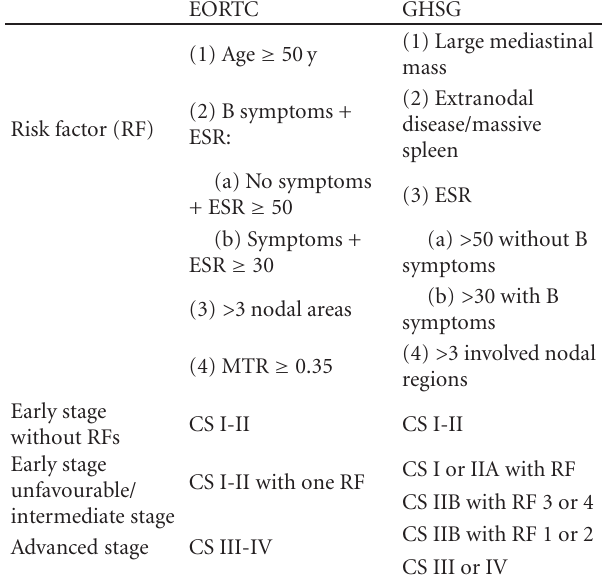
Table 1: Risk groups in CHL: clinical criteria used by European Organisation for Research and Treatment of Cancer (EORTC) and German Hodgkin Lymphoma Study Group (GHSG) to define treatment groups. Abbreviations: ESR, erythrocyte sedimentation